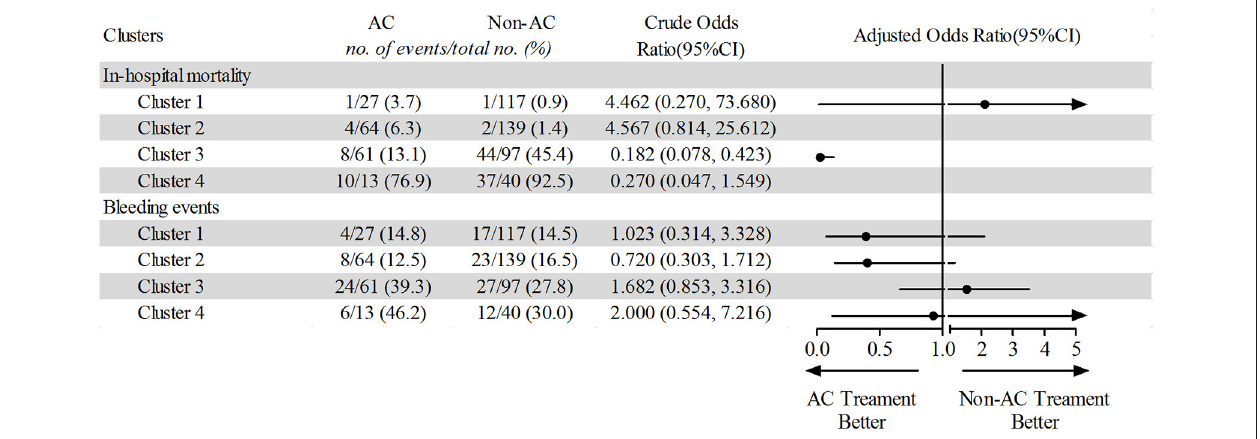
FIGURE 6 | Comparing of in-hospital mortality and bleeding events between AC treatment and non-AC treatment patients based on unsupervised machine learning. AC,